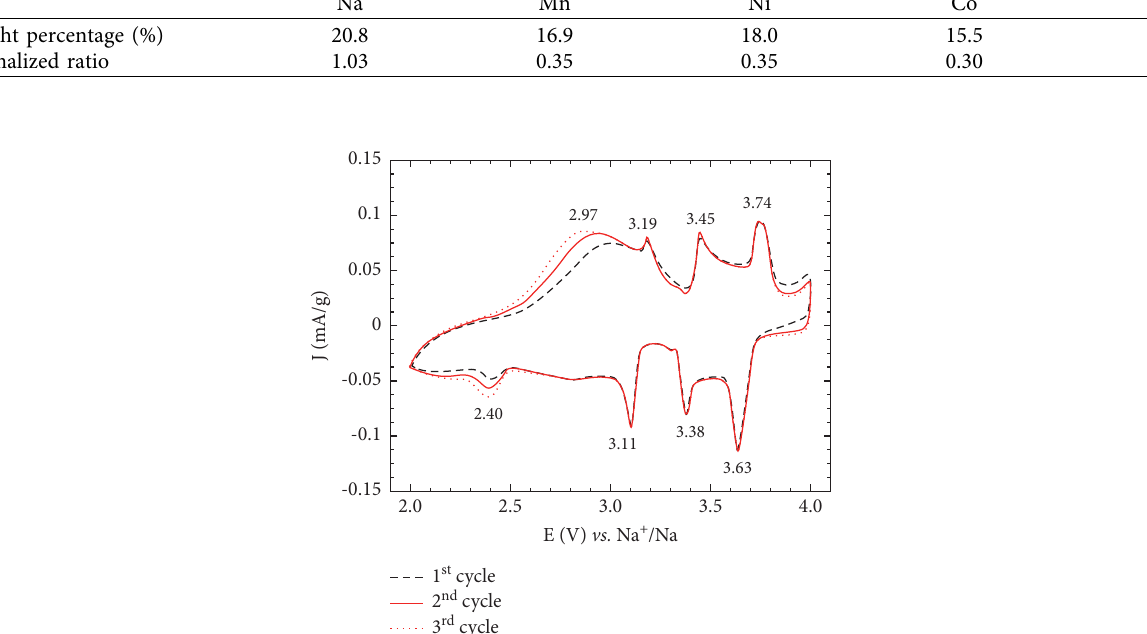
Figure 3: Cyclic voltammogram of the NaNMC cathode in the voltage range of 2.0–4.0V at the scanning rate of 100 μ V · s − 1 .